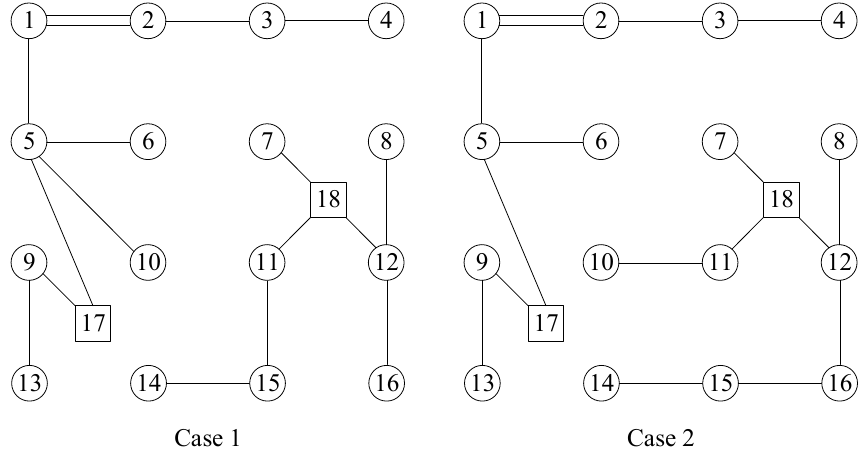
Figure 10. Power lines planning topologies of different cases in stage 3.